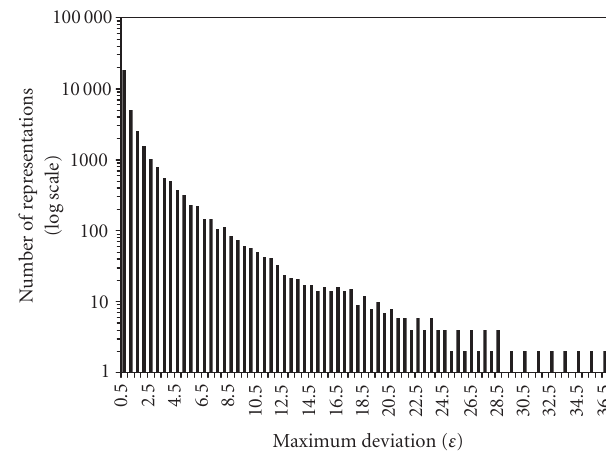
Figure 3: Histogram of error in coe ffi cient optimized high/low 2DLNS input